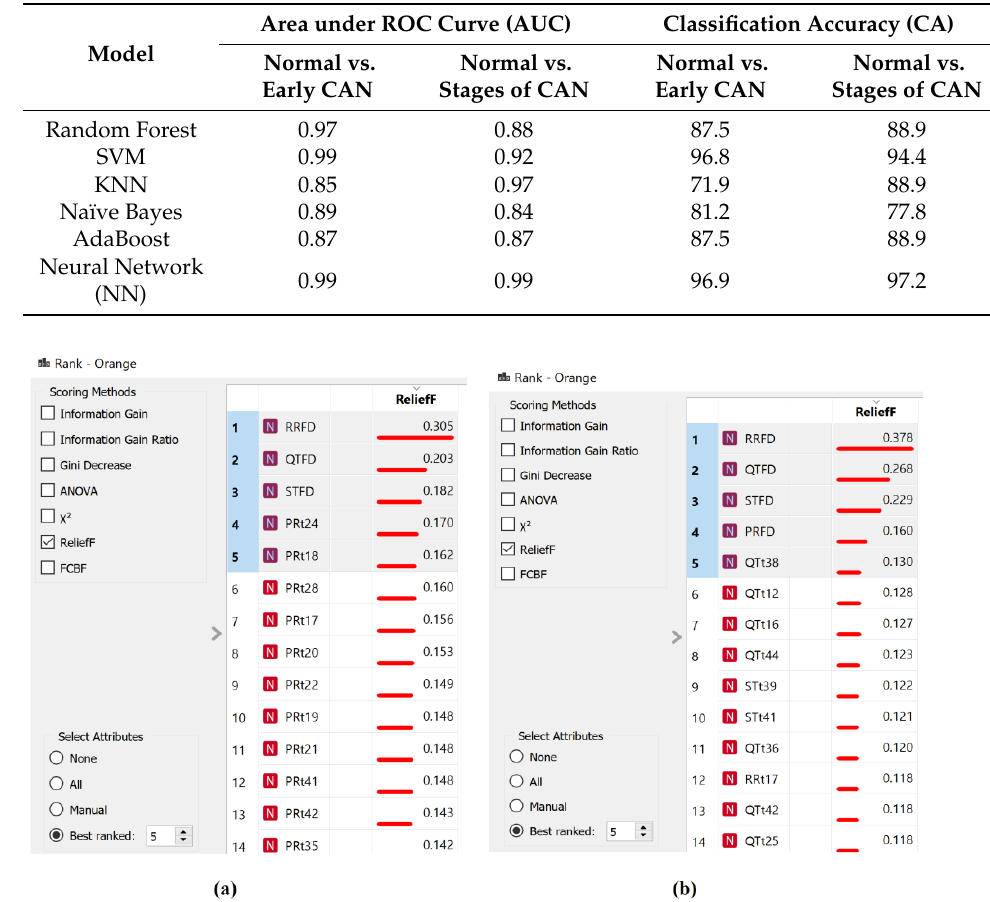
Table 5. Performance analysis of different supervised classifier models.